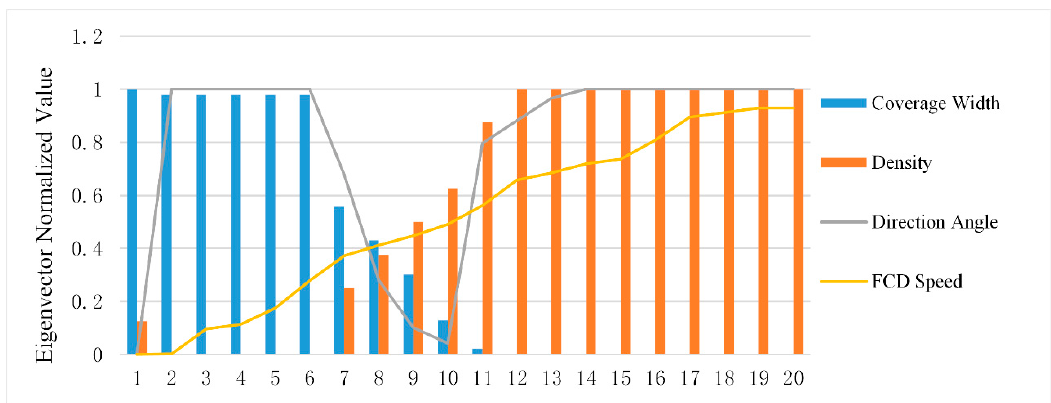
Figure 8. FCD Eigenvector normalized value.